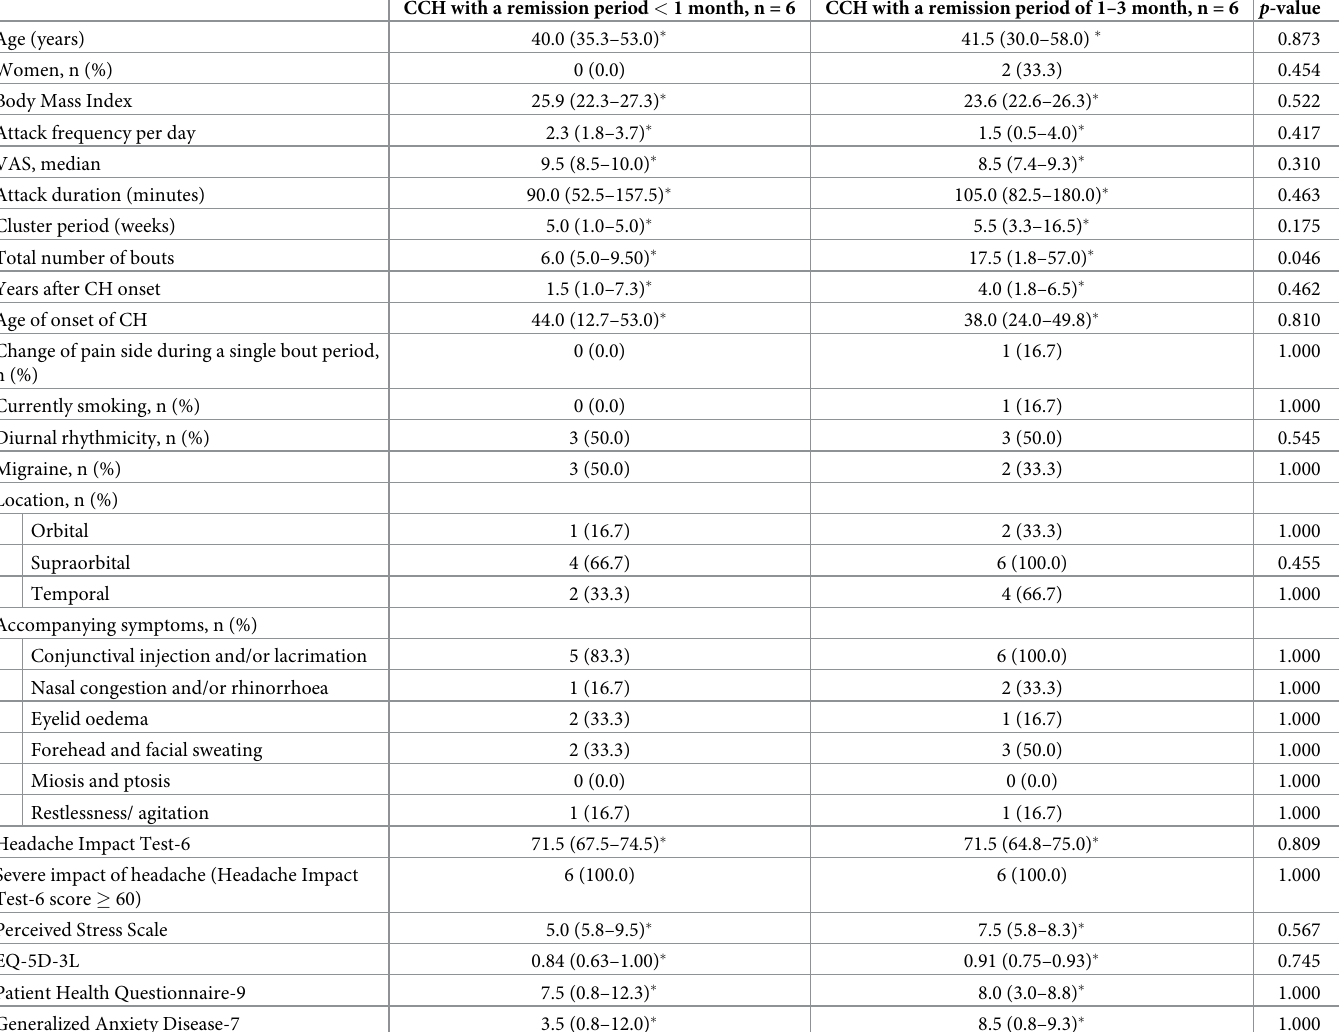
Table 2. Clinical features of participants with chronic cluster headache with a remission period < 1 month and chronic cluster headache with a remission period of 1–3